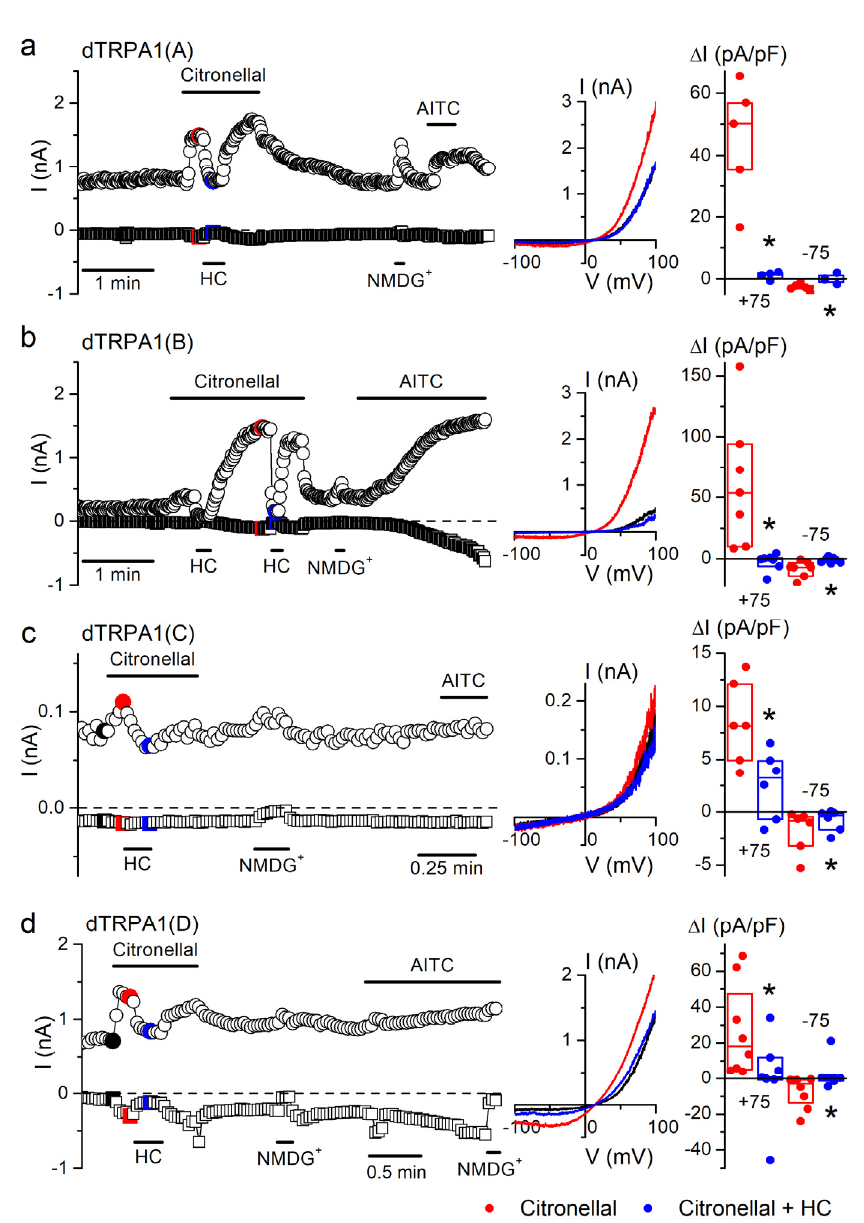
Figure 4. Citronellal increases whole-cell currents in the four dTRPA1 isoforms. ( a – d ) Examples of the effects of citronellal (1 mM), HC-030031 (HC; 100 µ M) and AITC (100 µ M) on the currents recorded at +75 mV (circles) and − 75 mV (squares) in whole-cell patch-clamp experiments in HEK293T cells expressing either dTRPA1(A), dTRPA1(B), dTRPA1(C) or dTRPA1(D). A solution where all cations were replaced by N-methyl-D-glucamine (NMDG + ) was used to assess the presence of leak currents [44]. The middle insets represent current traces recorded at the time points indicated by the corresponding colors in the left panels. The dot plots on the right represent the change in current density amplitude with respect to baseline values (recorded at +75 and − 75 mV). The horizontal lines represent medians and the boxes represent the 25–75 percentiles. Application of citronellal (1 mM, red symbols) induced whole-cell current increases in cells expressing: dTRPA1(A) ( p = 0.003, n = 5), dTRPA1(B) ( p = 0.01, n = 7), dTRPA1(C) ( p = 0.0016, n = 6) or dTRPA1(D) ( p = 0.01, n = 8, one-sample t -test vs. 0). The TRPA1 blocker HC-030031 (HC; 100 µ M) inhibited citronellal-induced (1 mM) currents (blue symbols) in cells expressing dTRPA1(A) ( p = 0.003, n = 4–5), dTRPA1(D) ( p = 0.024, n = 7–8; two-sample t -test), dTRPA1(C) ( p = 0.00006, n = 6) or dTRPA1(B) ( p = 0.018, n = 7; one tailed paired sample t